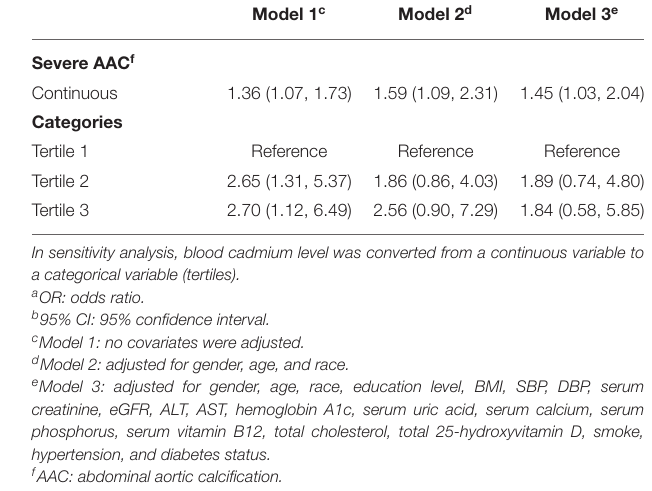
Frontiers in Cardiovascular Medicine |